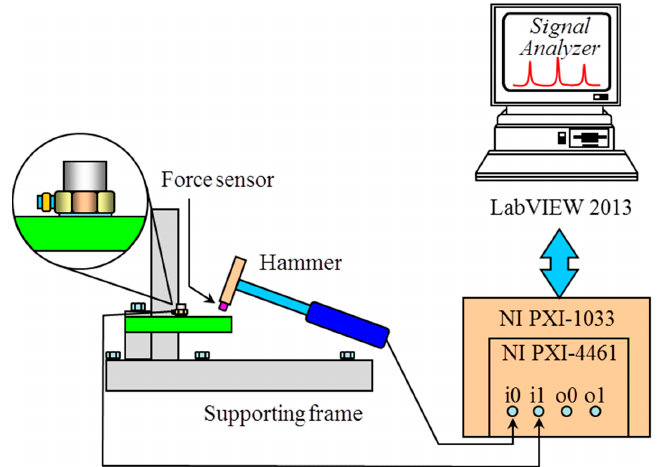
Figure 2. Vibration test apparatus.